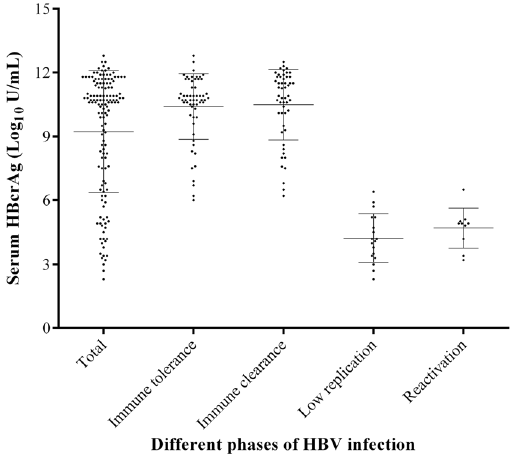
Figure 1. The distribution of serum qHBcrAg in different phases of CHB.